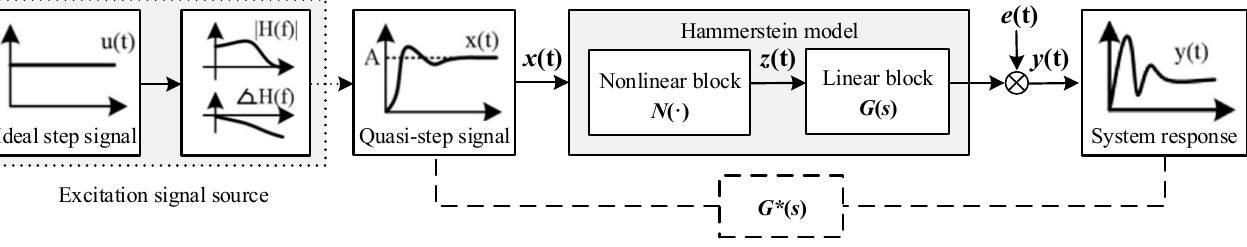
Figure 1. Hammerstein system identification under the excitation of a quasi-step signal.